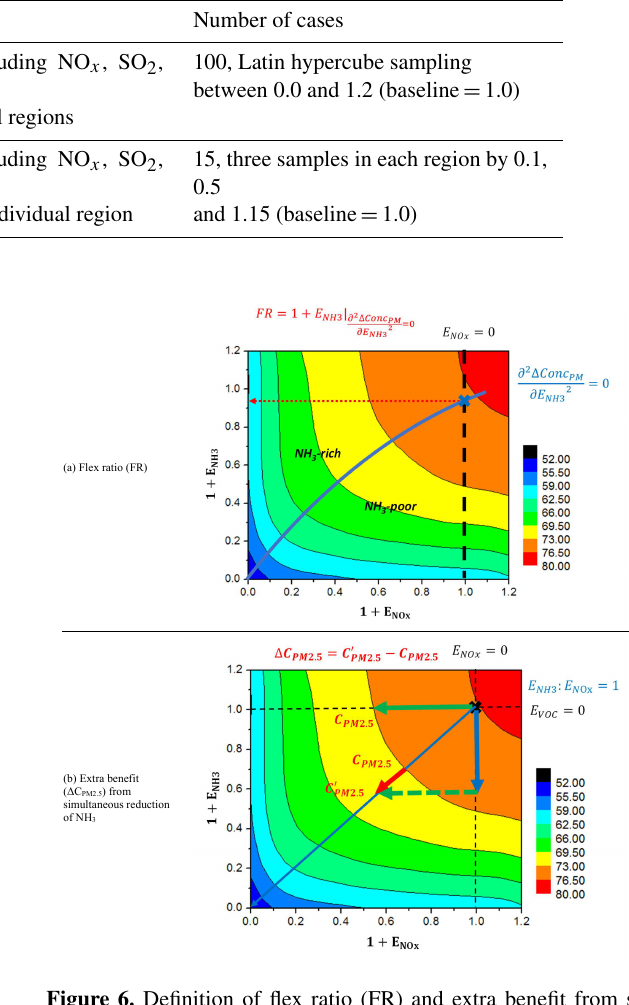
Figure 5. Definition of peak ratio (PR) and suggested VOC / NO x ratio basing on the 2-D isopleths of O 3 sensitivity to NO x and VOC emission changes (an example in Beijing in July).